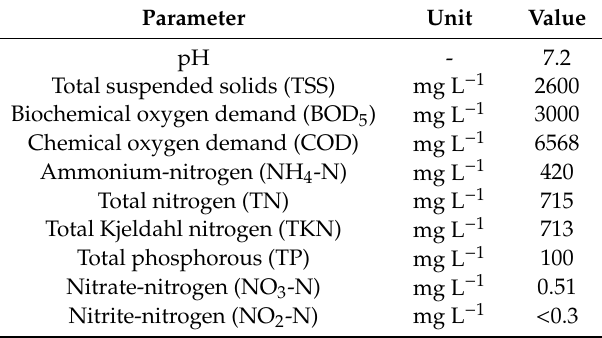
Table 2. Raw blackwater composition at the source-separation unit used for the experiment. Parameter Unit Value pH -